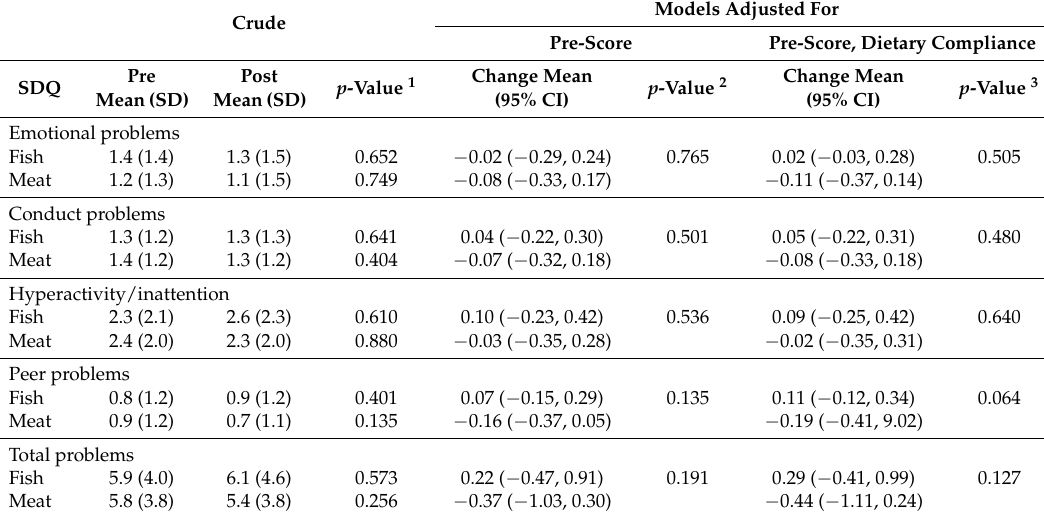
1 Paired-samples t -test for comparison of individual pre- and post-intervention values within each intervention group. 2 Linear mixed effect model adjusted for pre-intervention score. 3 Linear mixed effect model adjusted for pre-intervention score and dietary compliance (amount of fish/meat